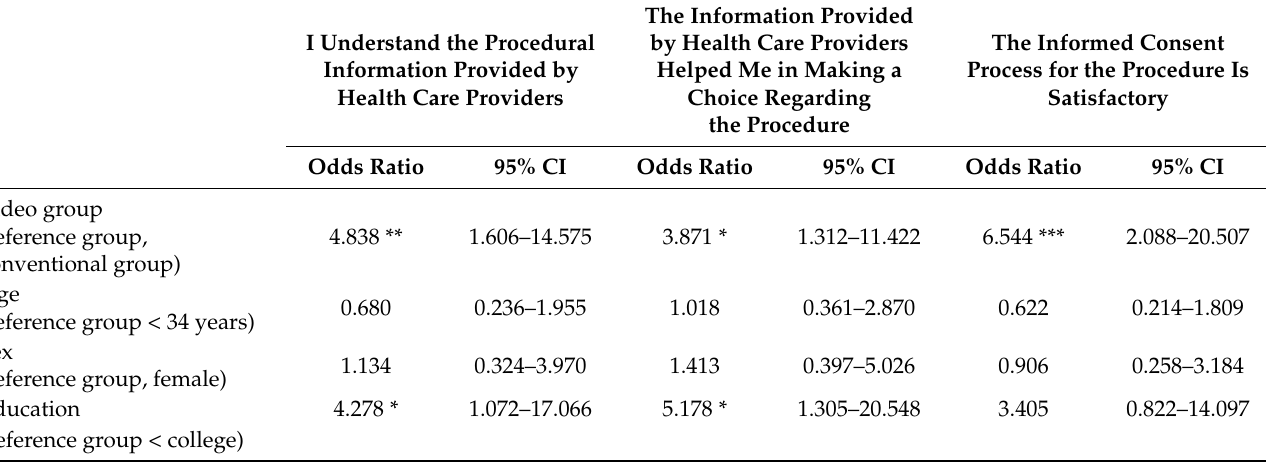
Table 5. Multiple ordinal logistic regression model for participant